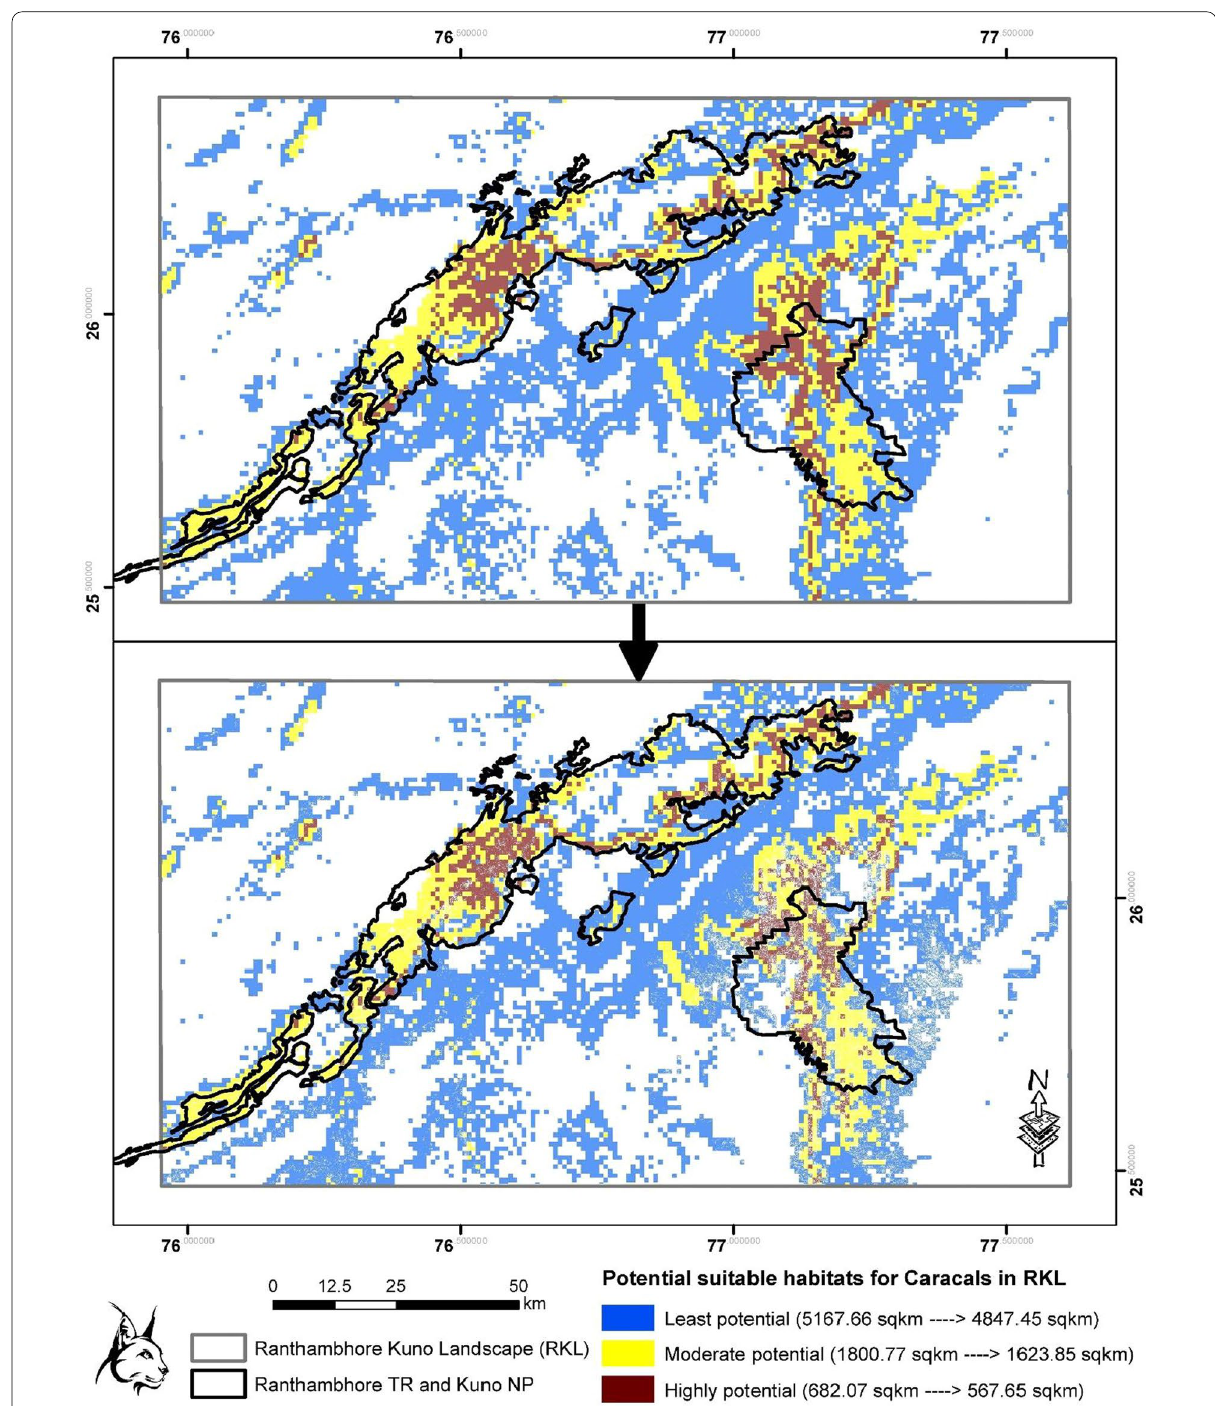
Fig. 4 Map depicting the potentially suitable habitats prior and after correction with vegetation height information in the Ranthambhore-Kuno Landscape (RKL) in central